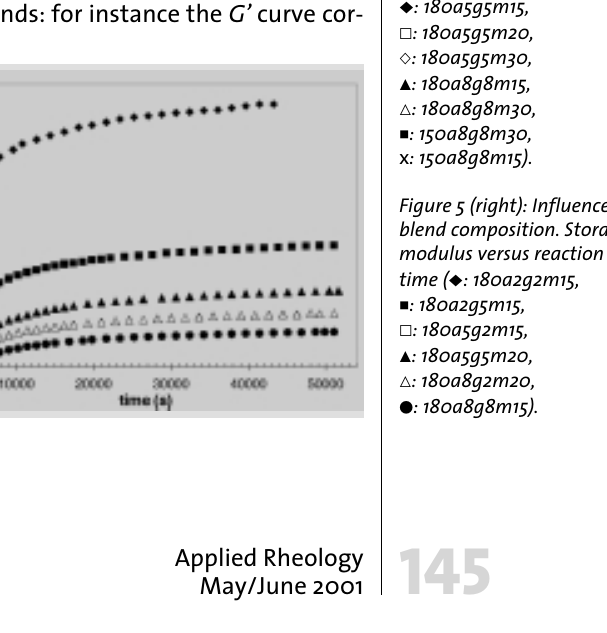
Figure 4 (left): Influence of mixing time. Storage modu- lus versus reaction time